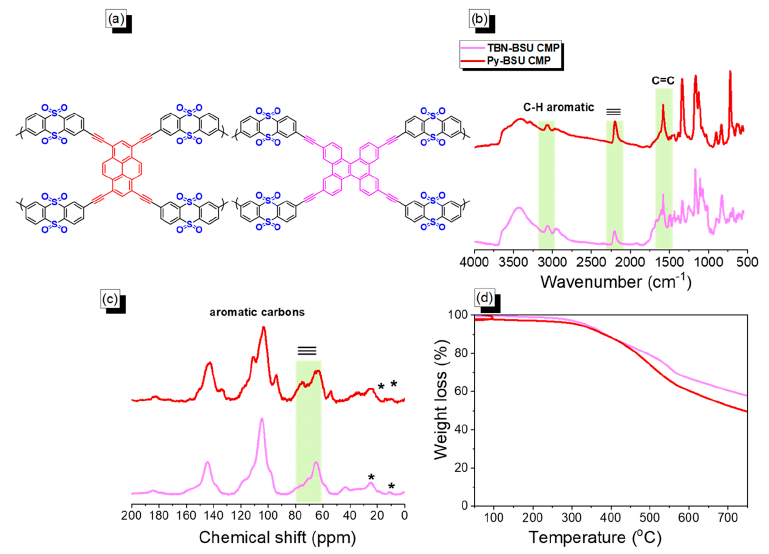
Figure 1. ( a ) Schematic diagram. ( b ) FTIR spectra, ( c ) SSNMR, and ( d ) TGA curves of Py-BSU CMP and TBN-BSU CMP. * the side band of solid-state nuclear magnetic resonance spectroscopy (NMR). Table 1. Thermal stabilities and porosity properties of Py-BSU CMP and TBN-BSU CMP.